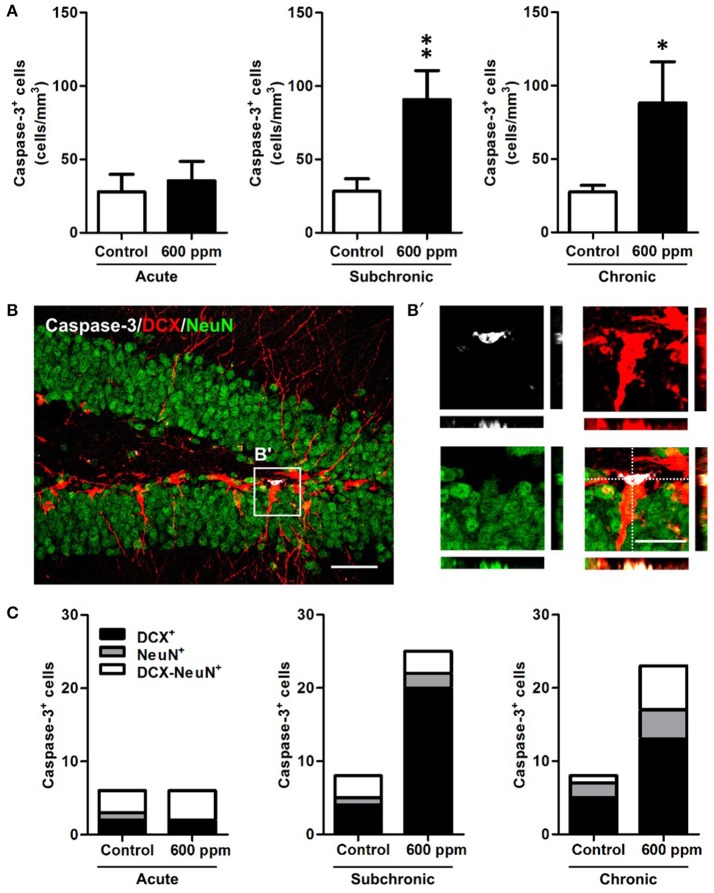
Enhanced apoptosis of DG newborn neurons following subchronic and chronic thinner inhalation. (A) Caspase-3+ cell density within the hippocampal DG in acute, subchronic and chronic groups in control and 600 ppm-treated mice. (B) Representative confocal image of the DG of a chronically treated animal labeled for Caspase-3 (white), DCX (red), and NeuN (green). Inset in (B) is displayed at higher magnification with re-slicing in (B') and shows a caspase-3/DCX double positive cell, negative for NeuN. (C) Relative proportions of DCX+, NeuN+, and DCX/NeuN+ cells among the total number of Caspase-3+ cells in acute, subchronic and chronic groups. Error bars indicate SEM (n = 5 per group). Student's t-test, *p < 0.05 and **p < 0.01 refer to the control vs. treated groups' comparison. Scale bar: 50 μm in (B); 15 μm in insets (B').